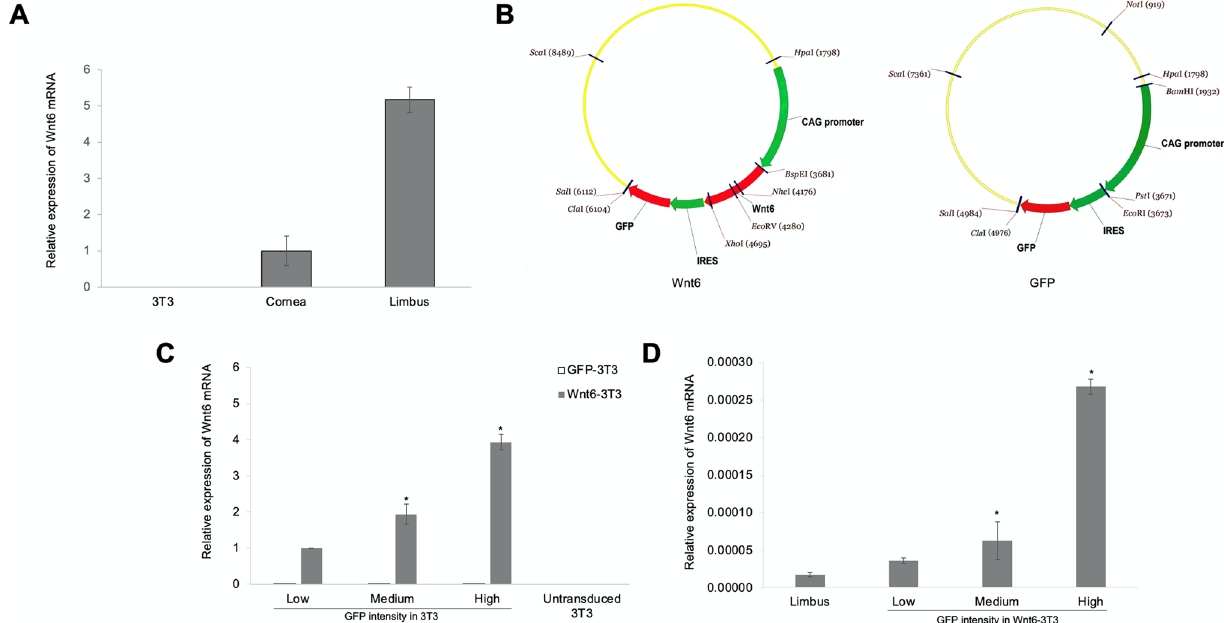
Figure 1. Expression of Wnt6. ( A ) mRNA from NIH-3T3 feeder cells, human corneal epithelium, and human limbal epithelium were reverse-transcribed and quantified by qRT-PCR. ( B ) NIH-3T3 feeder cells were transduced with lentiviral constructs over-expressing Wnt6 with an IRES-GFP reporter (Wnt6-3T3) or lentivirus containing the IRES-GFP reporter only (GFP-3T3) as the control. ( C ) Transduced 3T3 cells were sorted into 3 groups (low, medium, and high) based on their GFP intensities. The levels of Wnt6 expression in the 3 groups were examined by qRT-PCR. All mRNA levels were calculated as 2 −ΔCt values and normalized to GAPDH. * P ≤ 0.05 in comparison to the corresponding GFP-3T3 controls. Data are means ± SEM of 4 experiments. ( D ) The levels of Wnt6 mRNA expression in the low-, medium-, and high-Wnt6-3T3 cells were compared with human limbal expression of Wnt6 mRNA. All mRNA levels were calculated as 2 ( and normalized to 18S. Data are means ± SEM of 3 experiments. * P ≤ 0.0001 in comparison with the